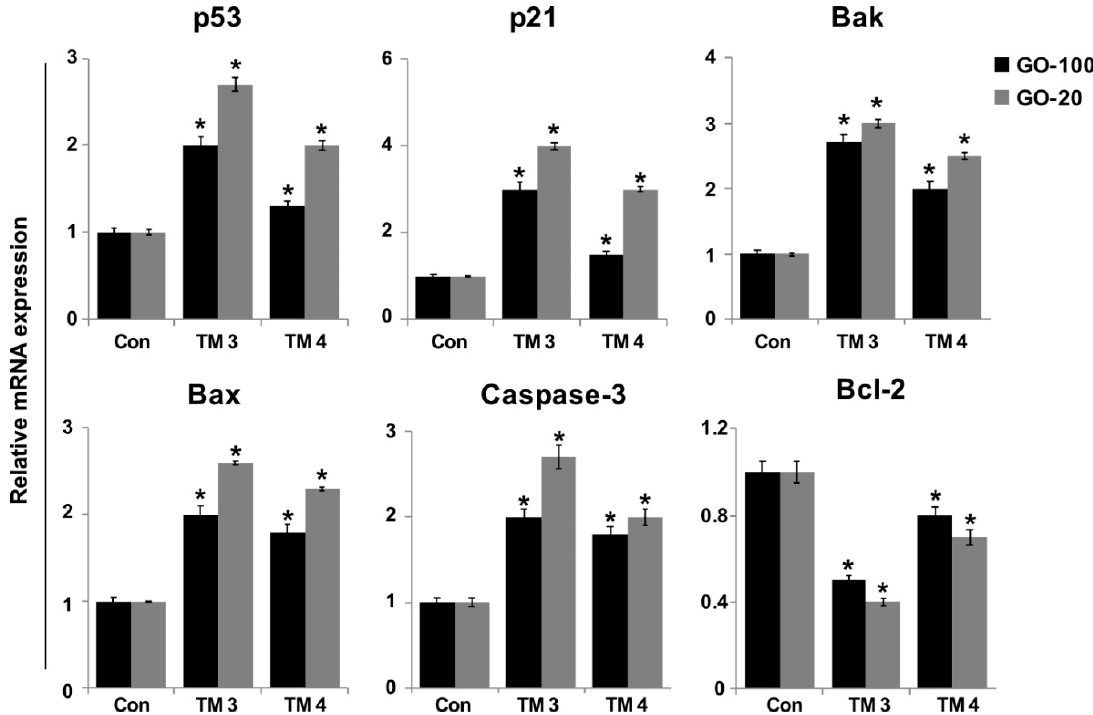
Figure 8. Effect of GO-100 and GO-20 graphene sheets on expression of pro- and anti-apoptotic genes. TM3 and TM4 cells were treated with GO (20–100 μ g/mL) and GO-20 (20–100 μ g/mL) for 24 h. After 24 h treatment, expression fold- levels were determined as fold- changes in reference to expression values of GAPDH . Results are expressed as fold changes. At least three independent experiments were performed for each sample. The treated groups showed statistically significant differences from the control group by Student’s t-test (* p < 0.05).